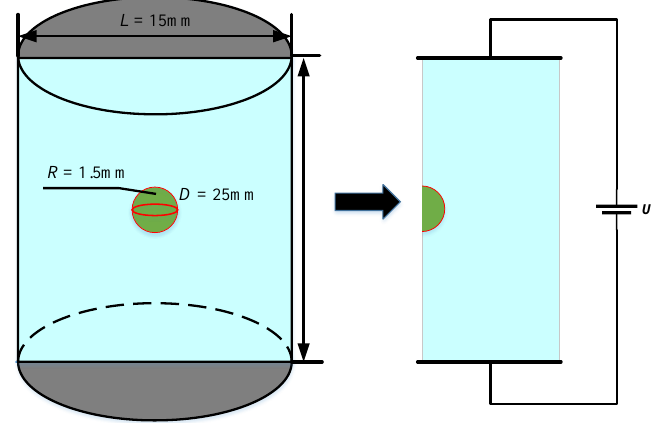
Figure 3. Electric field analysis model.